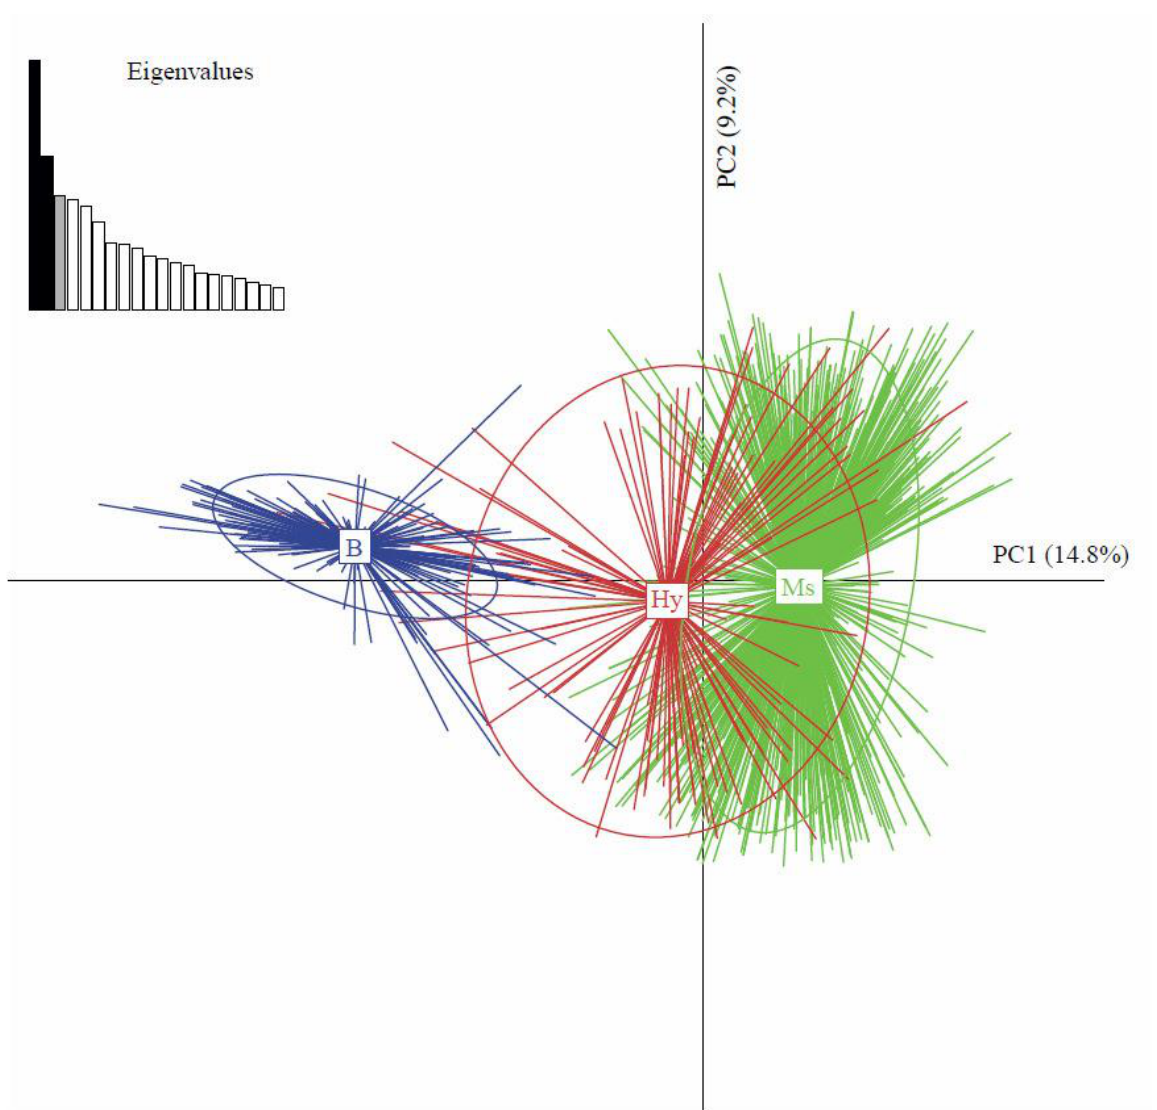
Figure 2 . Multivariate analysis of Bemisia tabaci populations in Reunion Island [72]. First and second components of a principal component analysis of 10-loci microsatellites from B. tabaci females from the three populations MEAM1 (biotype B), Hybrids (Hy) and Indian Ocean (biotype Ms) defined by STRUCTURE analysis. The relative contributions of the two first axes (PC1 and PC2) to the total genetic variation are 14.8% and 9.2% respectively. Eigenvalues corresponding to the represented components are in black. Populations are labeled inside their 95% inertia